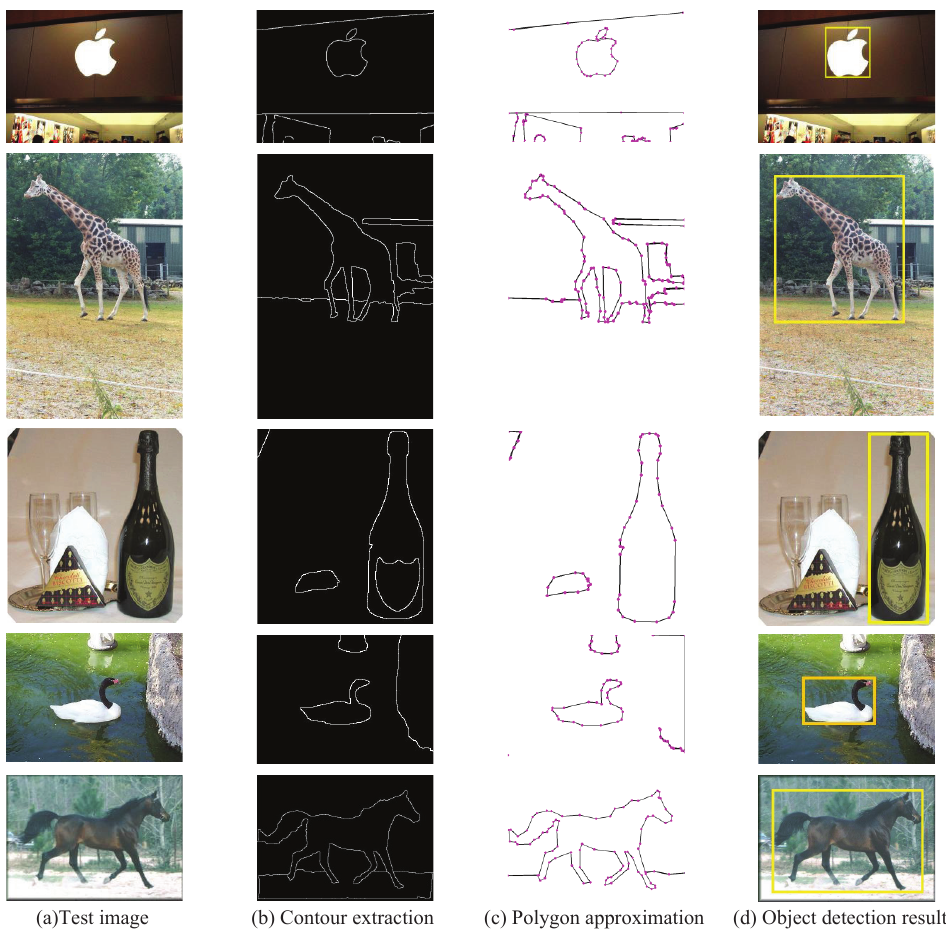
Figure 14. Some examples of detection